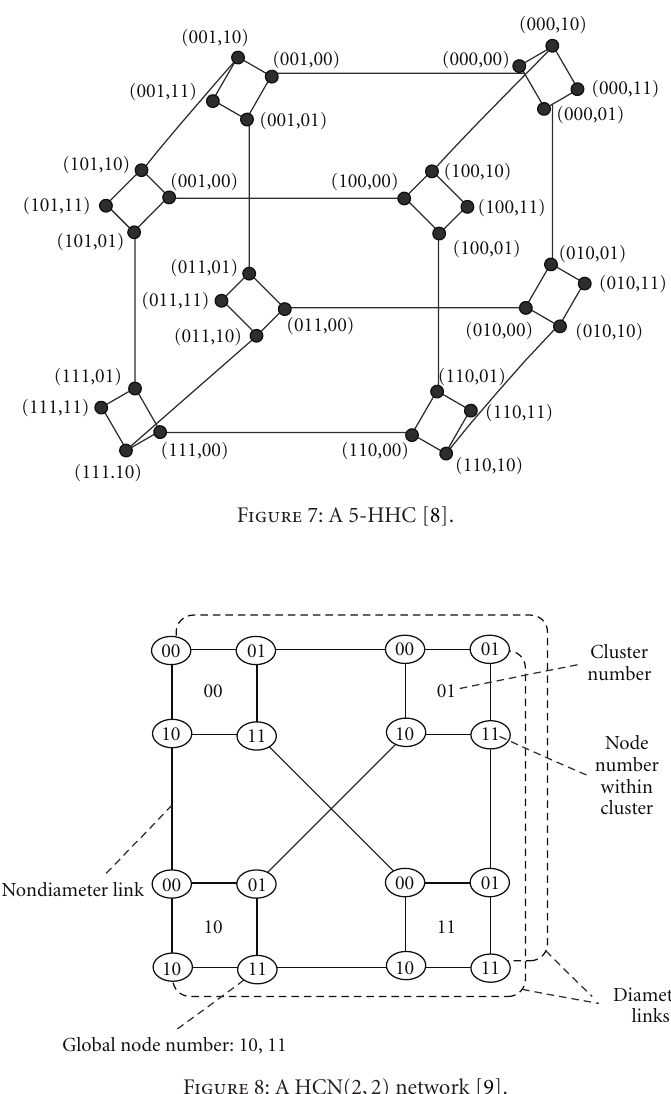
Figure 8: A HCN(2,2) network